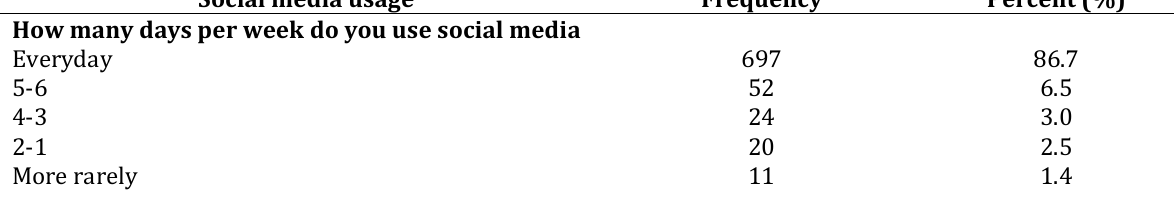
Table 2: Use of social media Social media